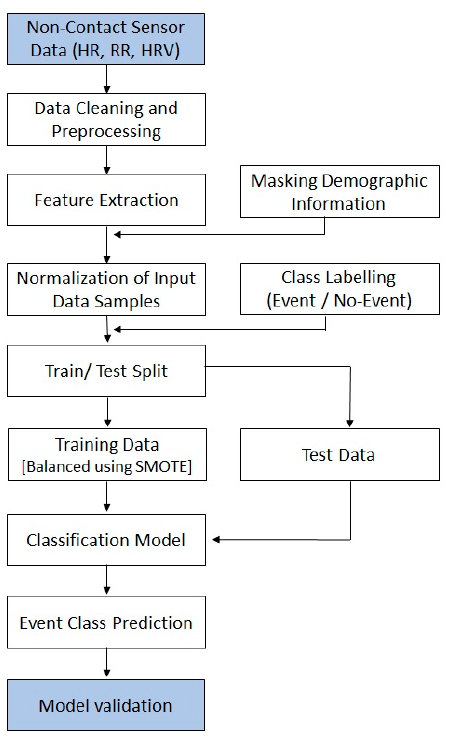
Figure 1. Prediction model for event class prediction. HR: Heart Rate; RR: Respiration Rate; HRV: Heart Rate Variability; SMOTE: Synthetic Minority Oversampling Technique.